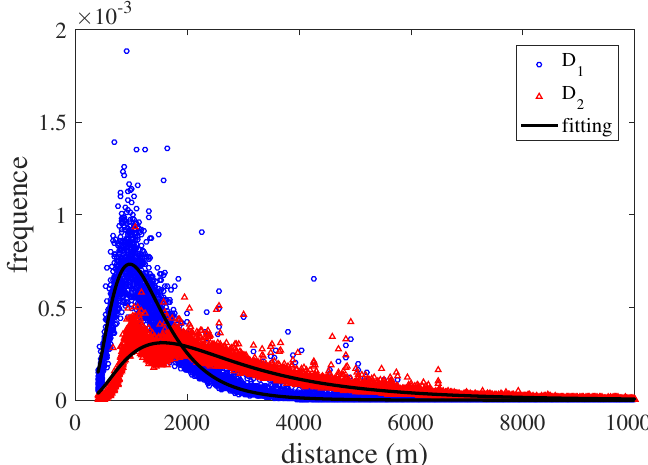
Figure 1. The distribution of the flow distance of dockless shared bikes. The blue circle represents the distance distribution obtained from D 1 , and the red triangle represents the distance distribution obtained from D 2 . The black line is the fitting line of the distance distribution with the lognormal distribution. The flow distance obtained from D 1 obeys a lognormal distribution with the parameters µ = 7.123, σ = 0.496, and the flow distance obtained from D 2 obeys a lognormal distribution with the parameters µ = 7.793, σ =